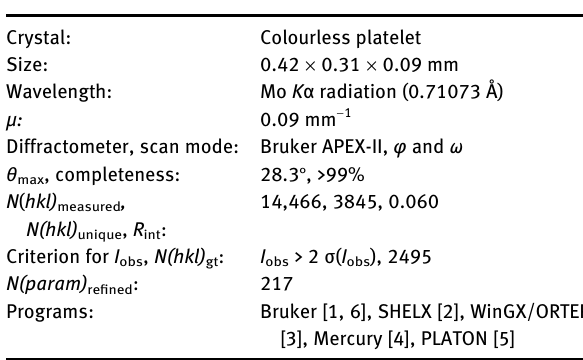
Table  : Data collection and